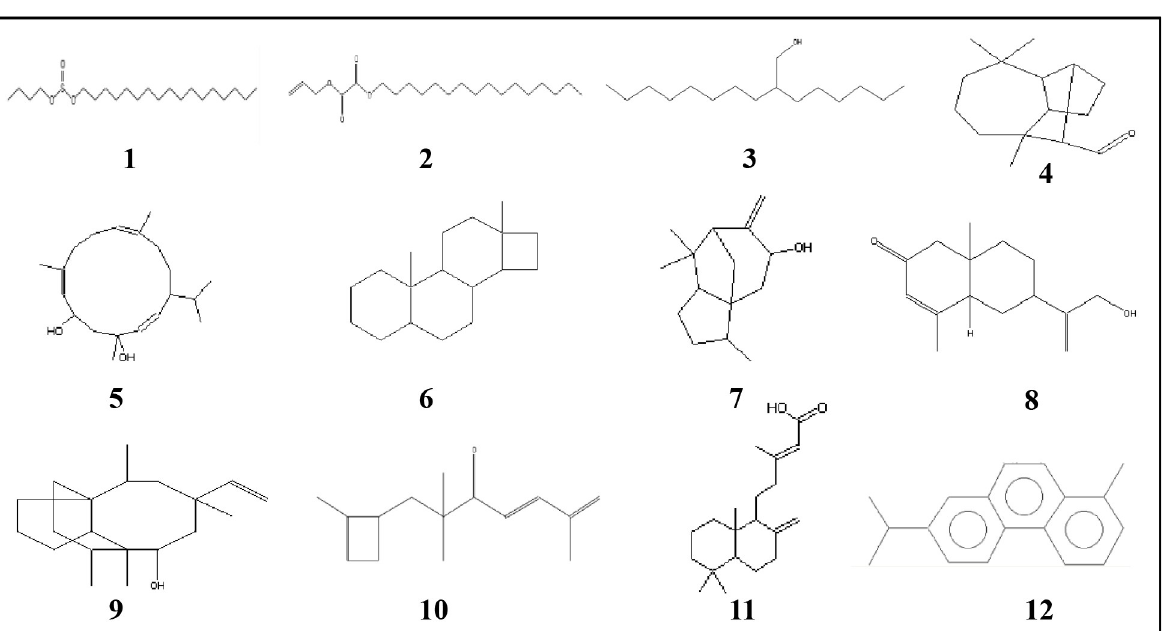
Fig 9. Chemical structures of twelve different compounds identified from band-C of EA fraction of AE1 by GC-MS analysis as mentioned in Table 3.